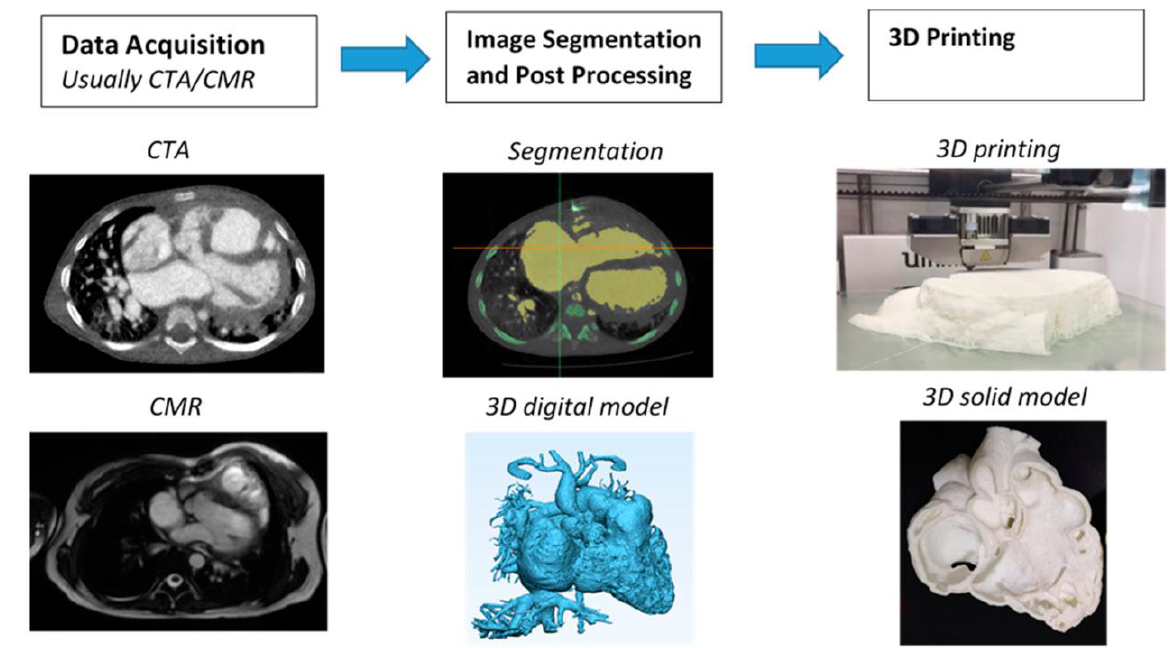
Figure 2. Steps involved in the creation of 3D-printed heart models using Mimics software for image post-processing and segmentation. CTA — computed tomography angiography, CMR — cardiac magnetic resonance, 3D — three-dimensional. Reprinted with permission under the open access from Sun et al. [33].